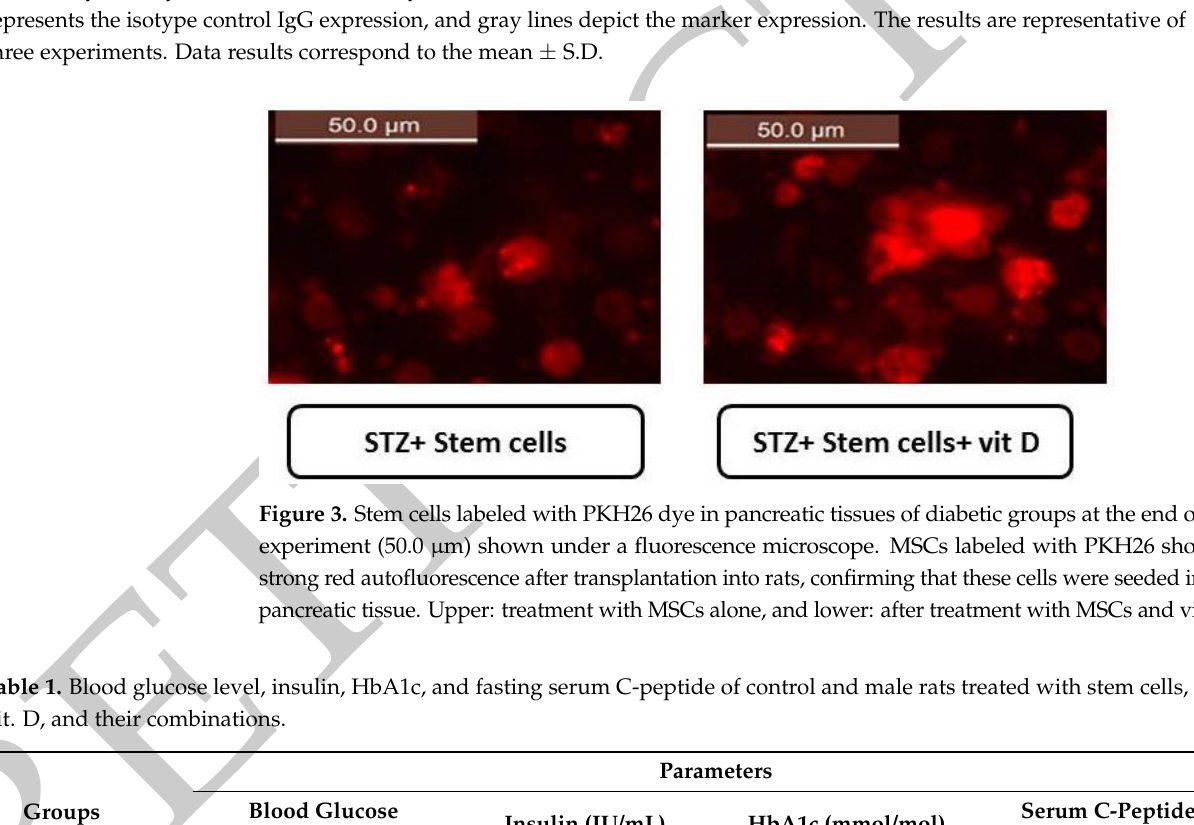
Data are presented as the mean ± SE. STZ: diabetic group, vit. D: vitamin D. Letters carrying different symbols are sig- nificant and assigned alphabetically. The values with the same letters are not significantly different, and the data with different letters are significantly different.